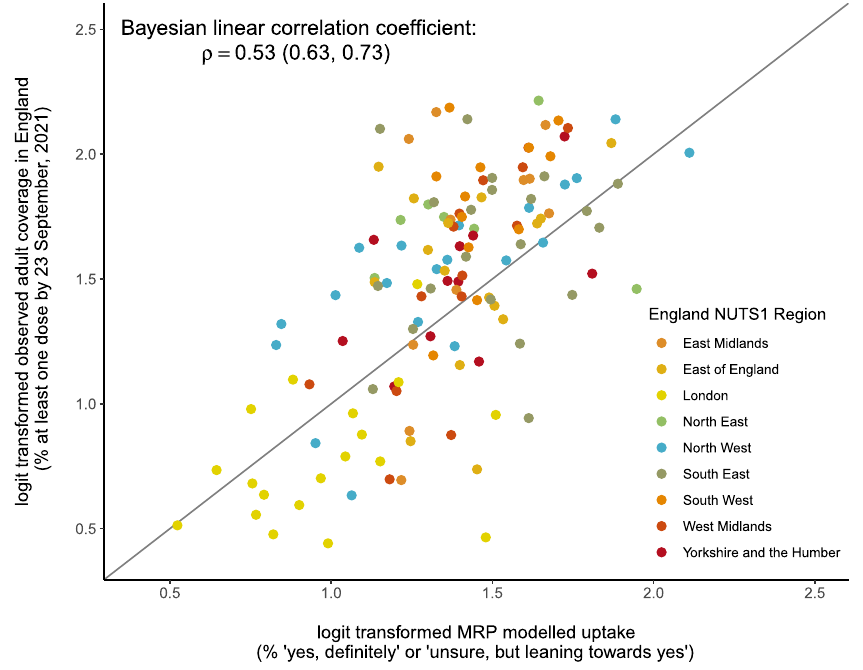
Figure 5. MRP forecasts of vaccine acceptance correlate with observed first-dose COVID-19 vaccine uptake among adults. (Logit transformed) observed vaccination coverage across all England NUTS-3 regions is plotted against (logit transformed) MRP predicted vaccine uptake. NUTS-3 regions are coloured by first administrative region (NUTS-1). The identity line is shown for